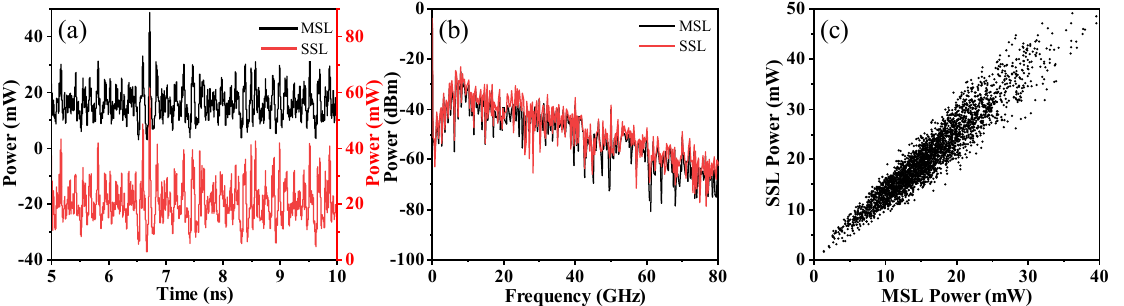
Figure 3. Synchronization diagram for two unidirectionally coupled modules in master/slave configuration. ( a ) Temporal waveforms, ( b ) RF spectra, ( c ) correlation plot.